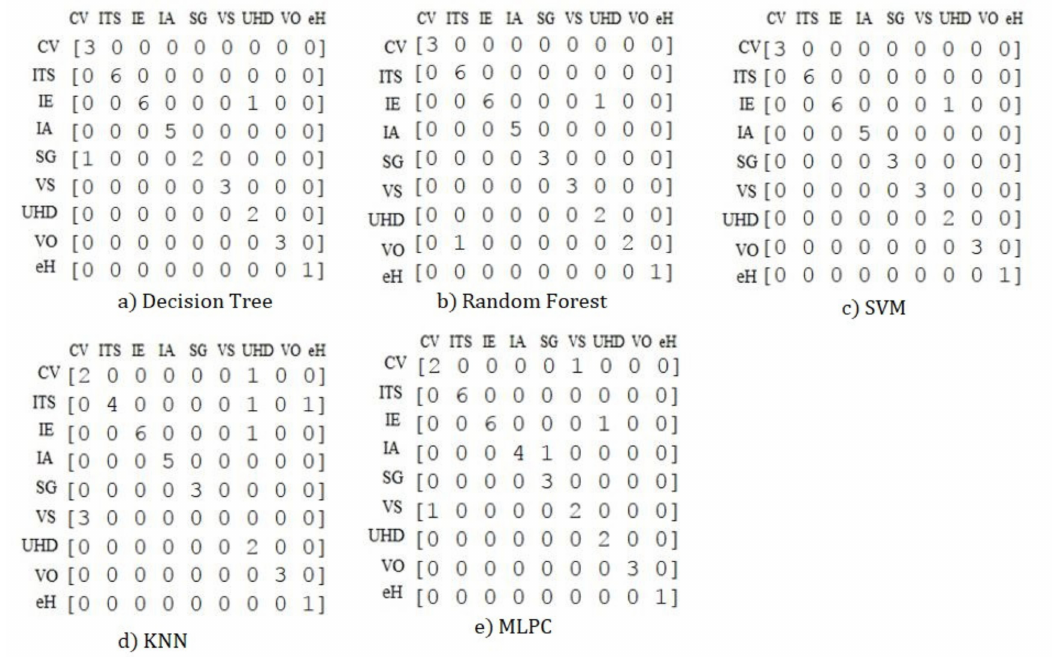
Figure 2. Confusion matrices for the first simulation (KPIs). CV: Connected Vehicles; IE: Immersive Experience; IA: Industry Automation; SG: Smart Grid; UHD: Video Streaming; VS: Video Surveillance; VO: Vo5G; eH: